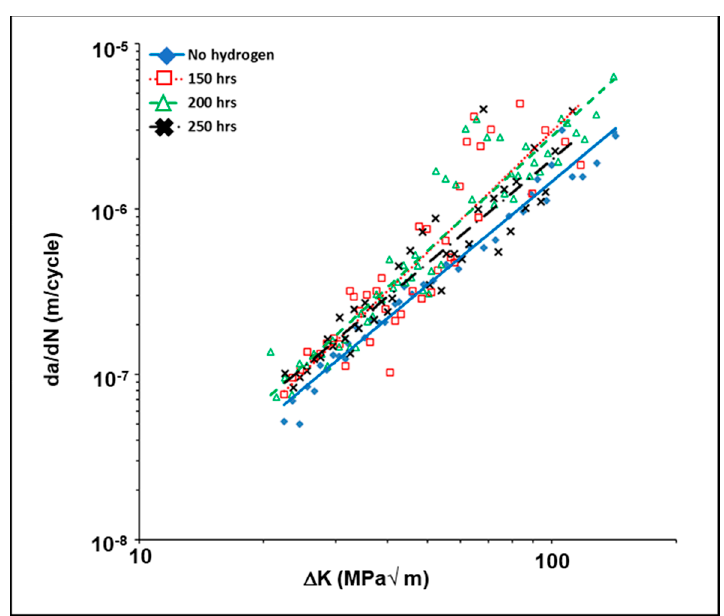
Figure 7. The Effect of Hydrogen Charging Time on the Fatigue Crack Growth Rate in the Linear Region for the Annealed 4140 Steel Samples.